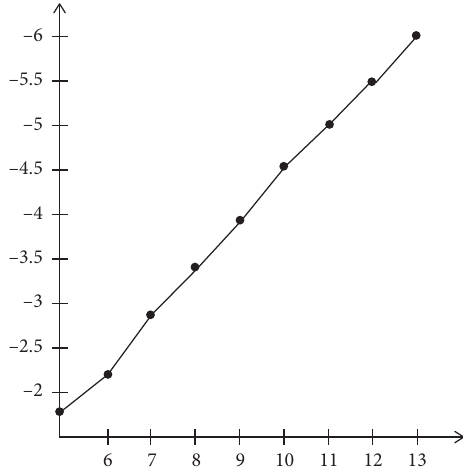
Figure 2: Relation between number of vertices and its corre- sponding least